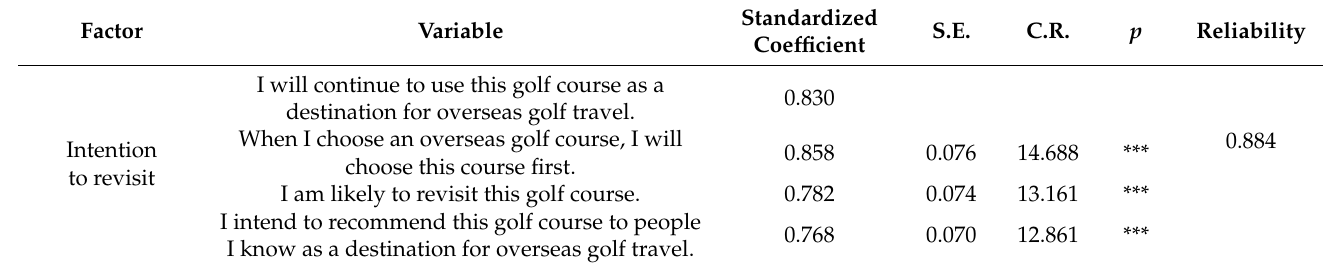
Table 6. The results of validity and reliability analysis for intention to